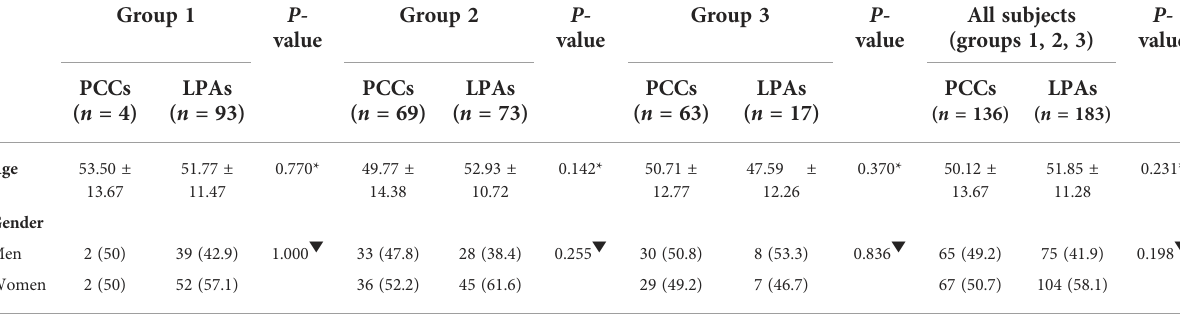
TABLE 1 Demographic characteristics between adrenal PCCs and LPAs on the training